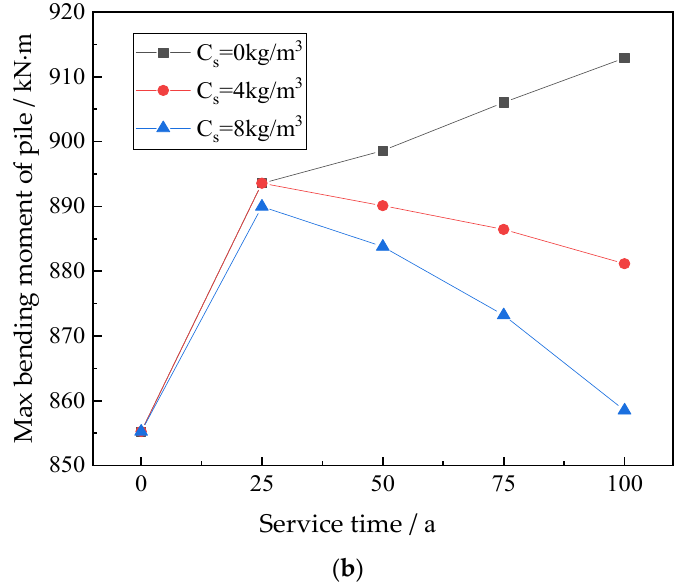
Figure 7. Stress and deformation diagrams for the pile under different chloride concentrations. ( a ) Relationship curve between the maximum horizontal displacement of the pile and service time. ( b ) Relationship curve between the maximum bending moment of the pile shaft and service time